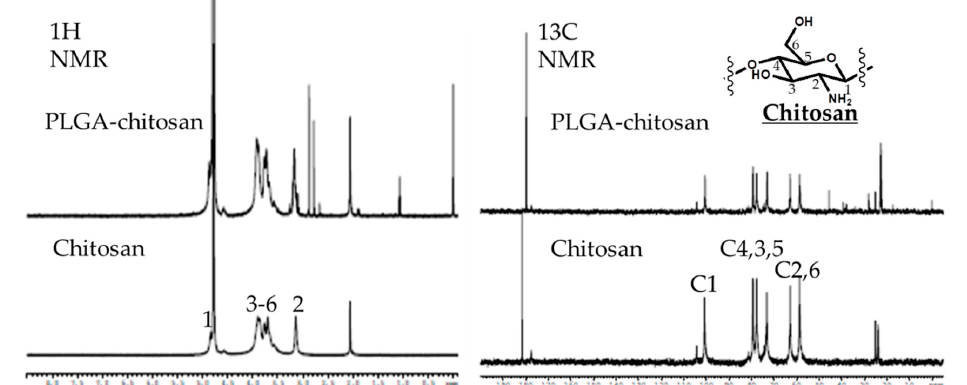
Figure 2. 600 MHz NMR Proton ( left panel ) and Carbon ( Right Panel ) analysis. Numbers indicate the Carbons (C1-6) of the chitosan ring structure or their respective hydrogens as depicted in the structure (Top right).